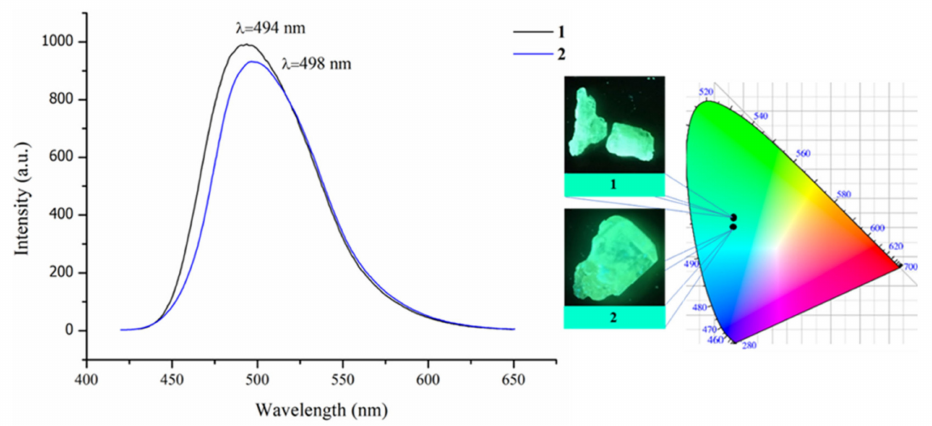
Figure 11. Emission spectra of 1 and 2 in the solid state at room temperature upon excitation at λ ex = 393 nm. Inset: Images of crystalline 1 and 2 under 365 nm UV-light and CIE color codes for the emission in the solid